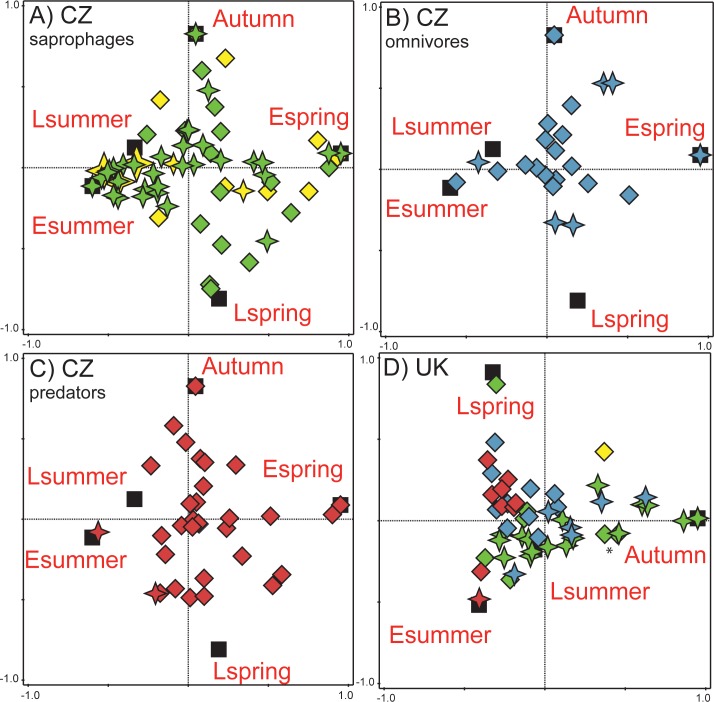
DCCA ordination diagrams of species seasonal segregation at both sites.Panels A, B and C represents the seasonal segregation of CZ species, all originating from one analyses (F = 12.6, P = 0.001). Those panels were created by including just one functional group for better visualization of results (A = saprophages (both adults and larvae coprophagous), B = omnivores (trophic switch between adults and larvae (usually adult saprophage, larva predator)), C = predators (= both adult and larvae predatory). Panel D represents the overall results of seasonal segregation in UK species (F = 17.3, P = 0.001). black squares = centroids of individual seasons (Espring = early spring (April–first half of May), Lspring = late spring (second half of May–June), Esummer = early summer (July), Lsummer = late summer (August–early days of September), Autumn = second half of September–October), diamonds = beetle species, stars = fly species, yellow symbols = relocators (larvae develop outside of the dung pat), green symbols = dwellers (larvae develop in the dung pats), blue symbols = omnivores, red symbols = predators, an asterisk (*) = the most abundant saprophage species in the UK data.